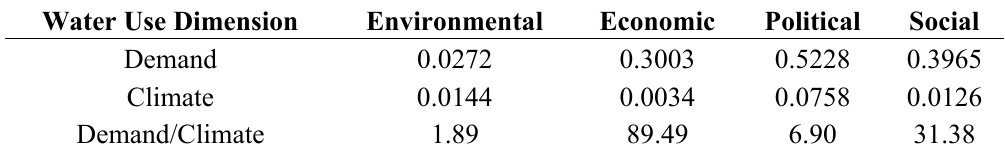
Table 11. Effect on SI caused by future variables (second variable held constant) and relative